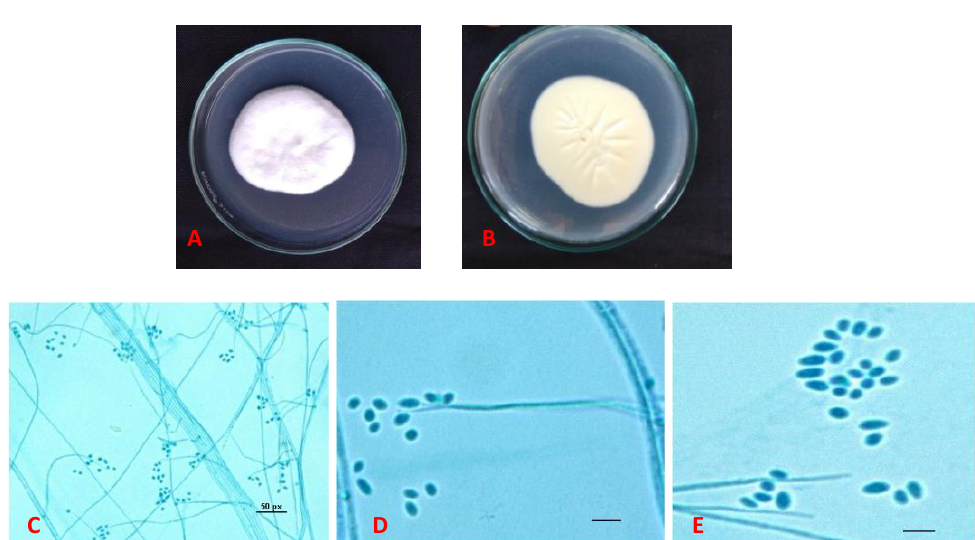
Figure 1. Morphological characters of Simplicillium lanosoniveum. ( A , B ) Simplicillium lanosoniveum cultured on PDA medium at 26 °C for 10 days ( A ) the front side ( B ) the reverse side ( C , D ) Conidio- phores with conidiogenous cells ( E ) Conidia — cylindrical, oval-ellipsoidal (2 – 4 × 1 – 2.0 μm); scale bar ( D , E ); 50 µm.